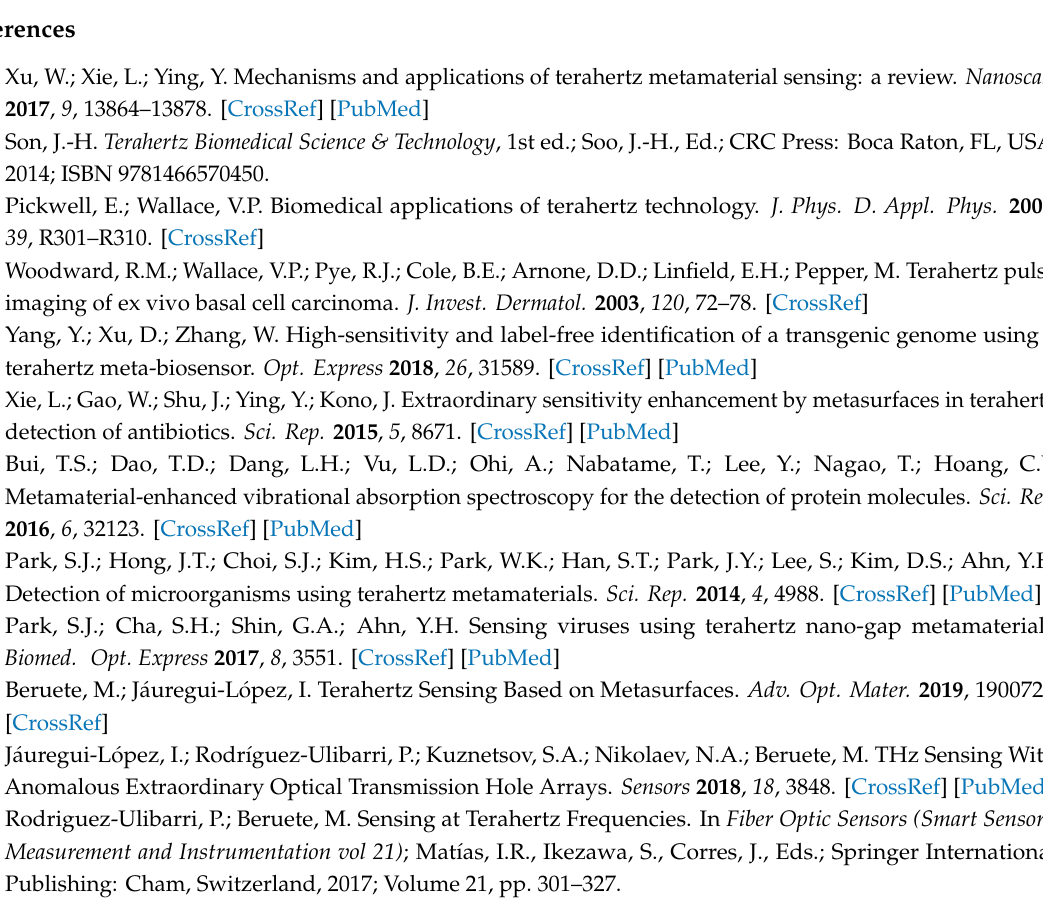
Table S1: Frequency resonance for all the simulations carried out for each fungi concentration, average and typical deviation for each